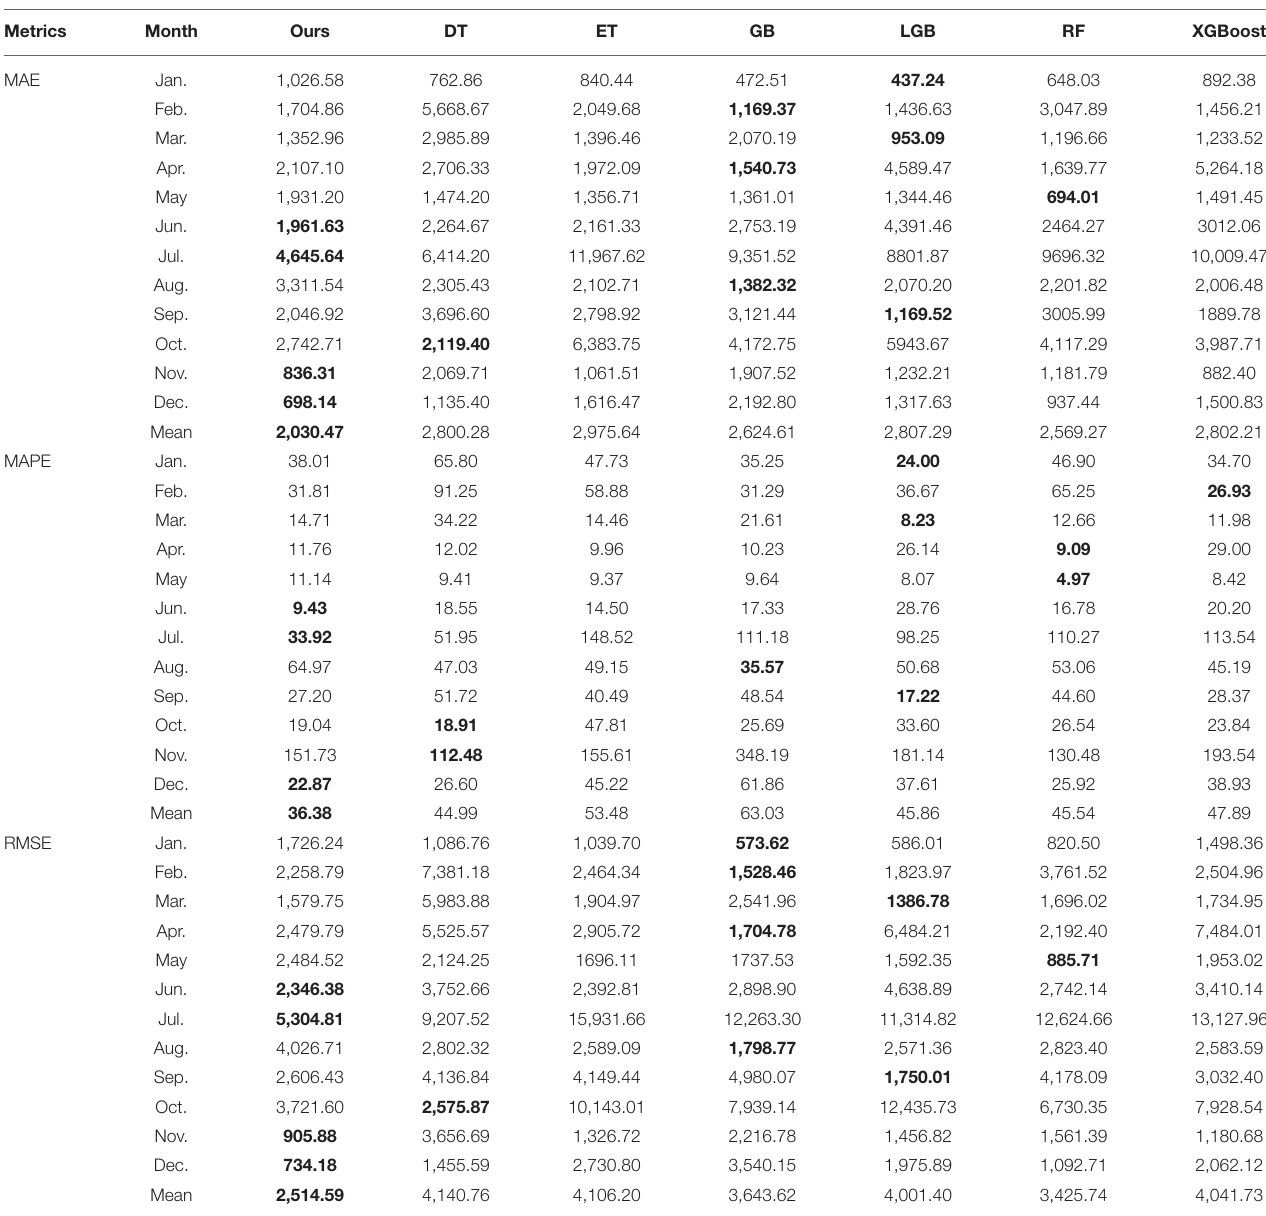
TABLE 4 | Forecasting results in 2021.